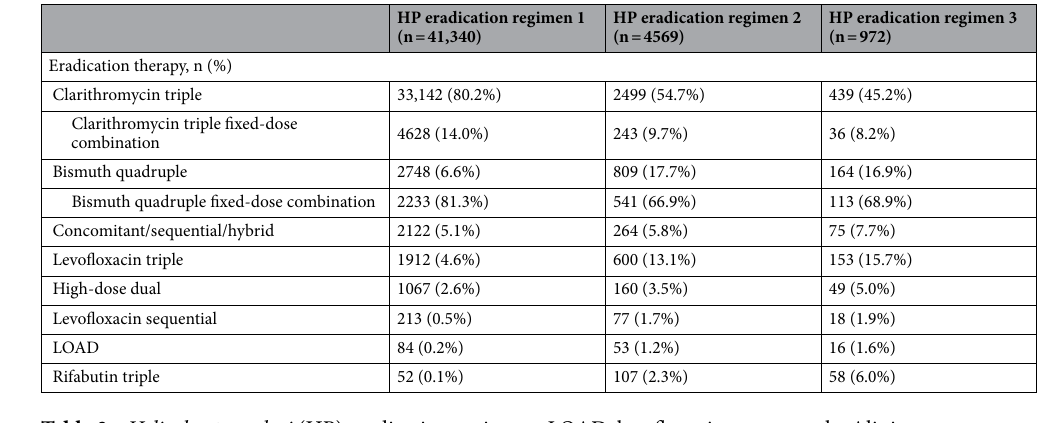
Table S3. This predominance of clarithromycin triple therapy persisted even after the publication of updated ACG guidelines in 2017, with 78.1% of those who initiated treatment in 2019 receiving clarithromycin triple therapy. Among the 85.3% (n = 35,264) of patients who received a clarithromycin-containing regimen as first-line therapy (clarithromycin triple therapy or concomitant/sequential/hybrid therapy), 21.0% had a prescription for a macrolide antibiotic recorded during the 12-month baseline period. While only 5.3% of guideline-treated patients used a levofloxacin-based regimen (levofloxacin triple or sequential therapy or LOAD) as first-line therapy, 35.3% had a prescription for a fluoroquinolone antibiotic during baseline. Overall, 45.3% (n = 27,445) of patients either did not receive a guideline-recommended treatment or received a potentially inappropriate regimen based on prior antibiotic use. Among the 11.1% (n = 4569) of guideline-treated patients who received a second US guideline-recommended eradication regimen, clarithromycin triple therapy remained the most common (54.7%) regimen for second-line treatment, followed by bismuth quadruple therapy (17.7%) and levofloxacin triple therapy (13.1%). The mean